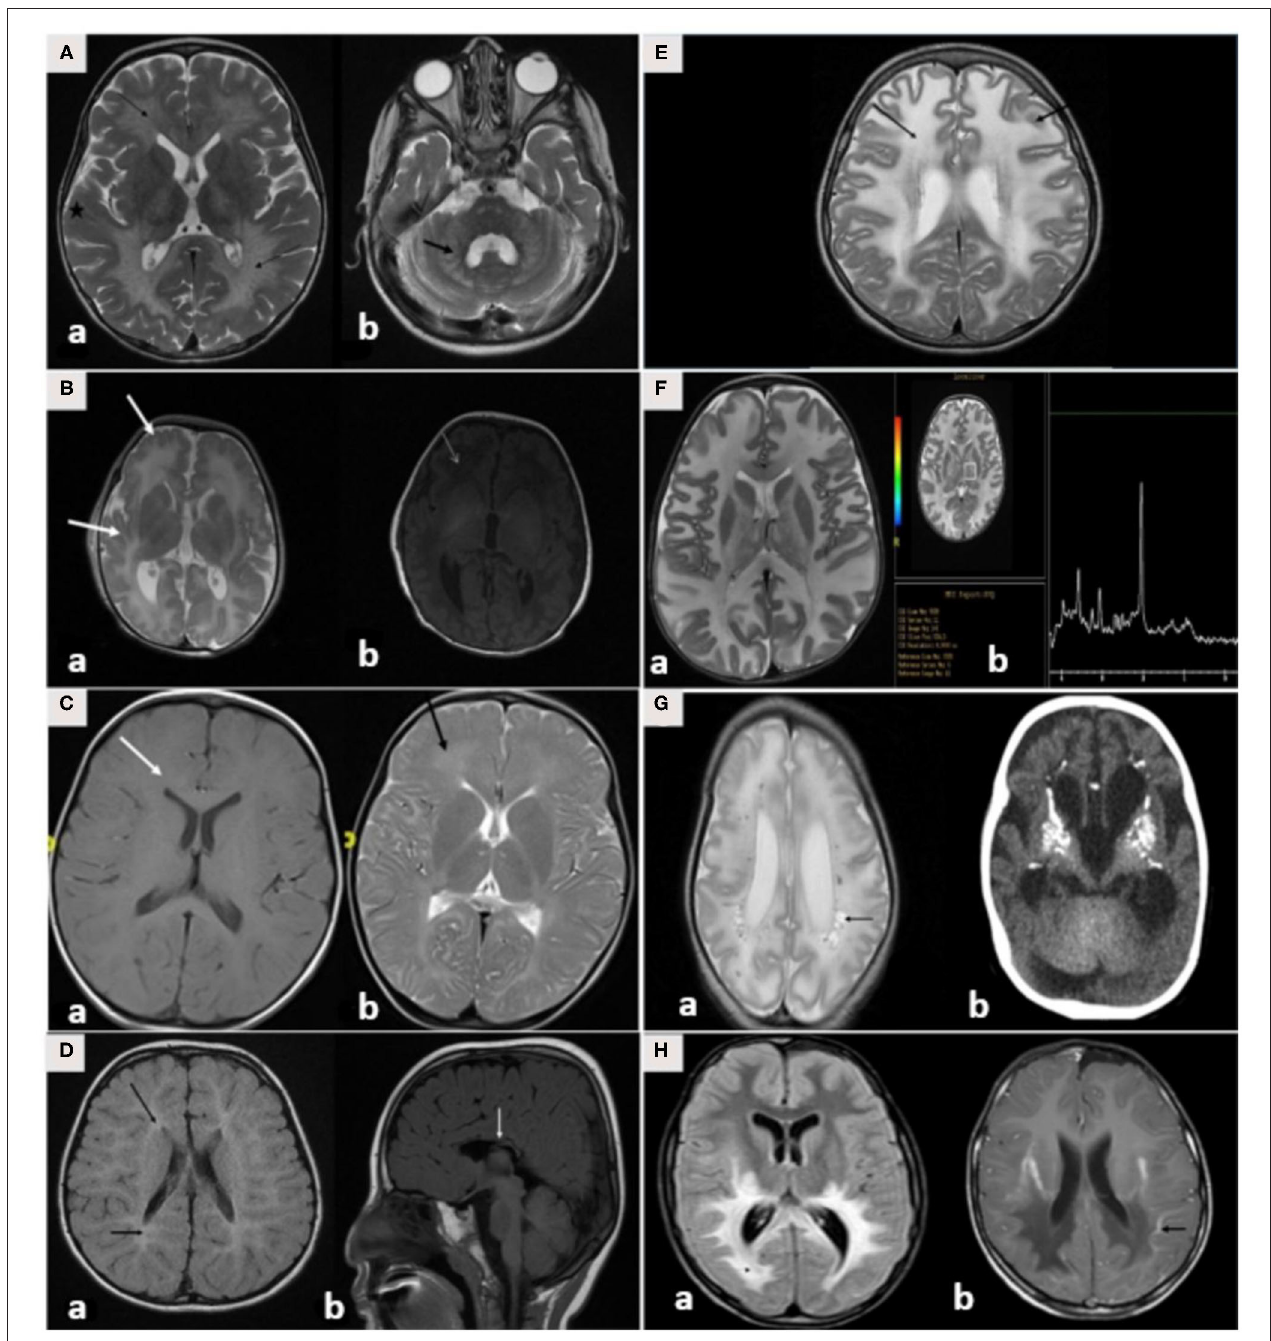
FIGURE 3 | (A–H) MRI/CT brain of patients included in this study. (A) Brain MRI of a 30-month-old boy with metachromatic leukodystrophy. (a) Axial T2WI demonstrates bilateral symmetrical confluent areas of periventricular deep white matter signal change (thin arrow) with sparing of subcortical U-fibers (star). Note the classic tigroid pattern. (b) Axial T2WI exhibits bilateral involvement of the cerebellar white matter (thick arrow) and the pons. (B) Brain MRI of a 10-day-old boy with Zellweger syndrome. (a) Axial T2WI shows malformation of the cerebral cortex in both sylvian fissures (thick arrow) extending into the pericentral cortex and right parietal cortex as well as at the mesial aspect of the hemispheres in the form of a polymicrogyric pattern. (b) Axial T1WI shows an excessive hypointensity of the deep and subcortical white matter and also noted in the bilateral frontoparietal white matter (thin arrow). (C) Brain MRI of a 3-year-old boy with GJC2-hypomyelating leukodystrophy. (a) Axial T1WI shows iso/low signal intensity of the white matter (white arrow). (b) Axial T2WI exhibits an increased signal intensity of cerebral hemispheric white matter (black arrow). (D) Brain MRI of a 4-year-old boy with Salla disease. (a) FLAIR-WI demonstrates abnormal periventricular white matter signals (black arrow). (b) Sagittal T1WI shows thin dysplastic corpus callosum (white arrow). (E) Brain MRI of 11-year-old girl with megaloencephalic leukodystrophy with